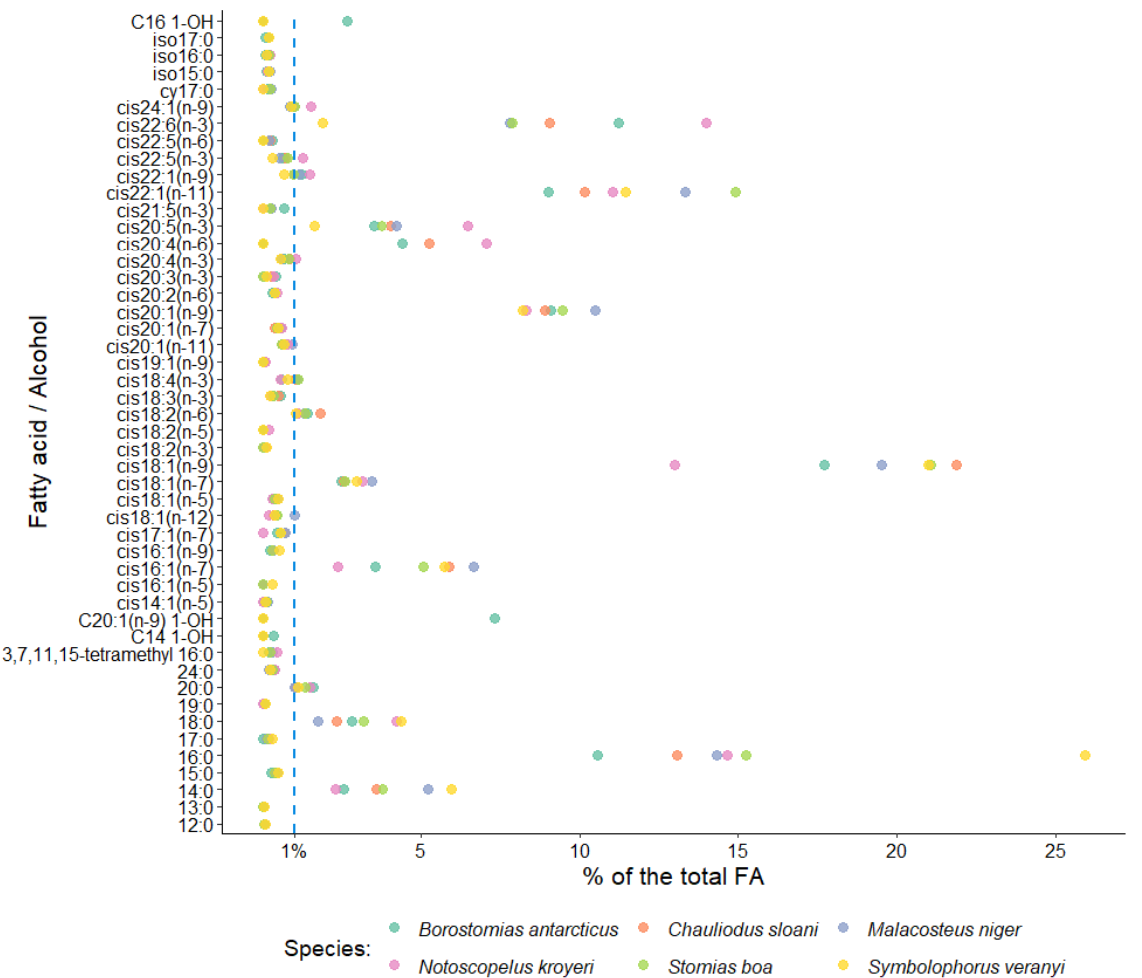
Figure 3. Average levels of some fatty acids in muscle tissues of mesopelagic fishes ( Notoscopelus kroyeri , Symbolophorus veranyi , Chauliodus sloani , Stomias boa , Malacosteus niger , and Borostomias antarcticus ) across the depth gradient in the Irminger Sea (North Atlantic).